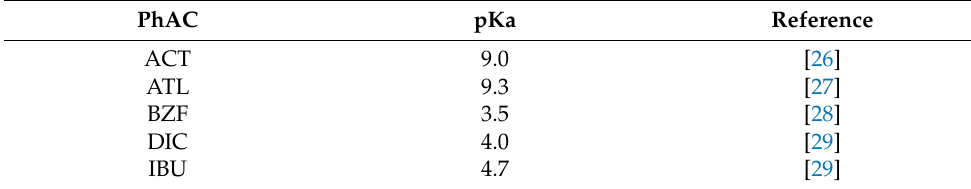
Table 3. Experimental values of pKa for the PhACs used in the experiments. PhAC